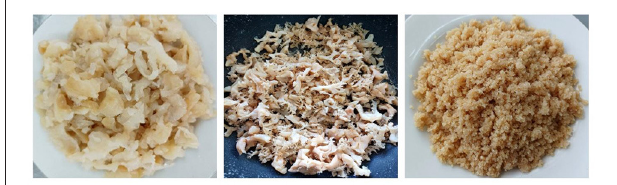
FIGURE 1 | Characteristics of jellyfish, roasted jellyfish, and ground jellyfish.